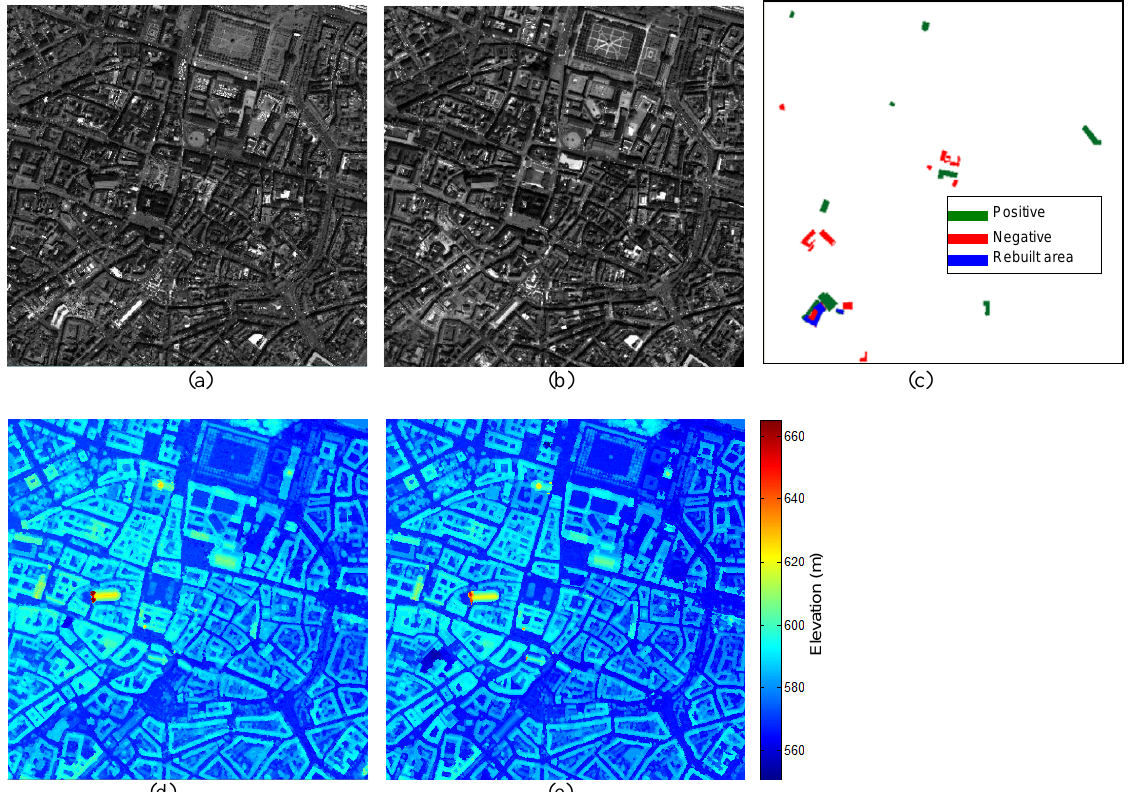
Figure 3. Dataset for Munich test area, including orthorectified panchromatic image from date 1 (a) and date 2 (b), change reference map (c), DSM from date 1 (d) and date 2 (e).